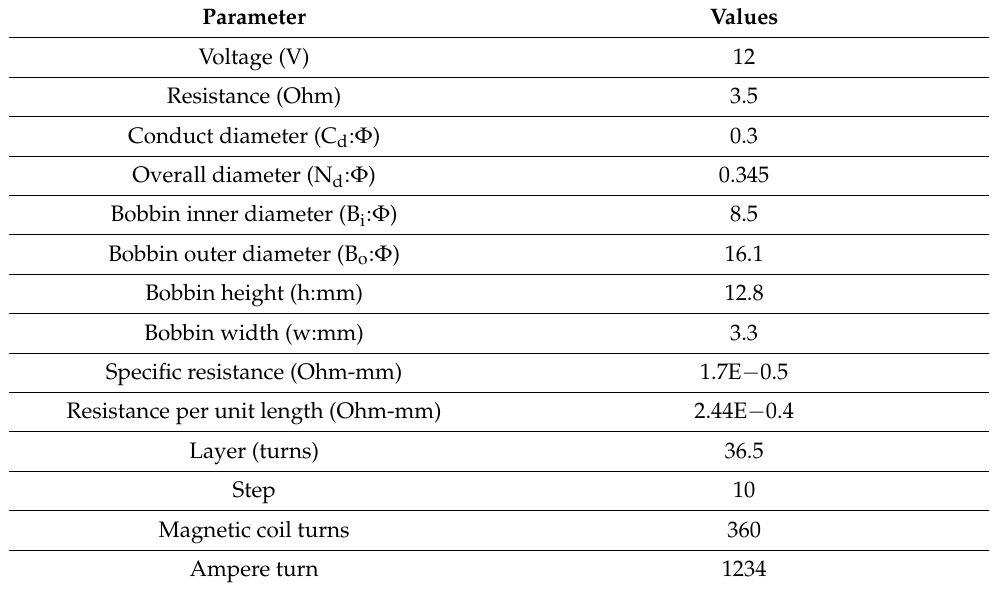
Table 1. Design parameters of the magnetic coil winding.